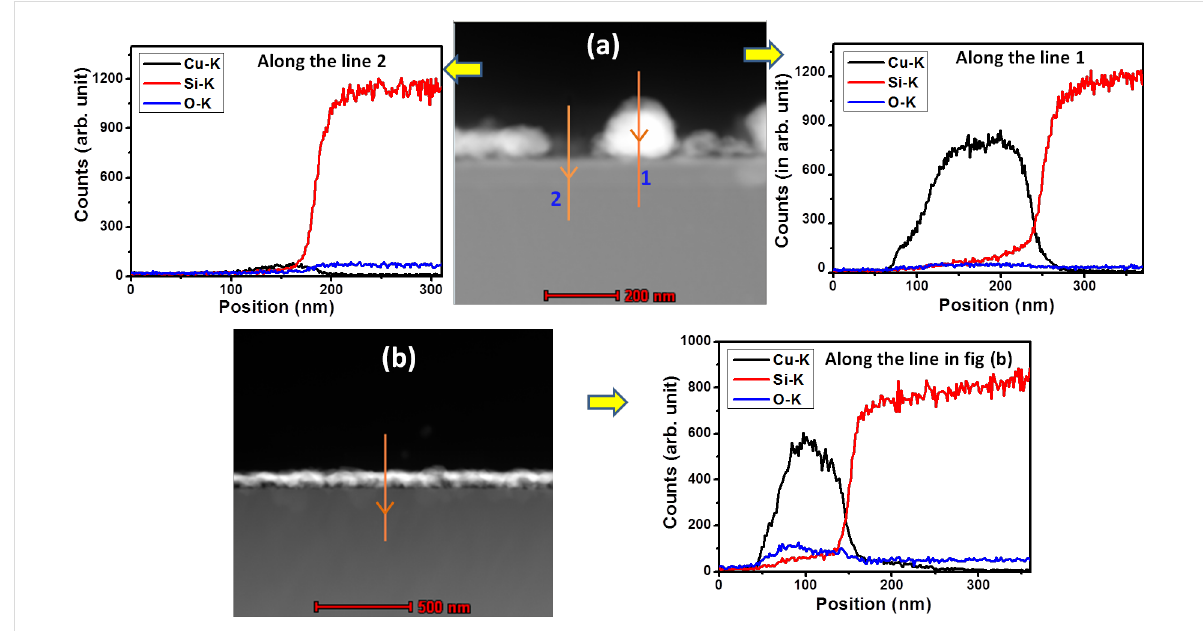
Figure 5: Copper, silicon and oxygen elemental line profiles collected from the region indicated by the arrows in the STEM-HAADF images of (a) as-deposited copper nanoparticles and (b) copper nanoparticles oxidized to CuO on the silicon substrate.